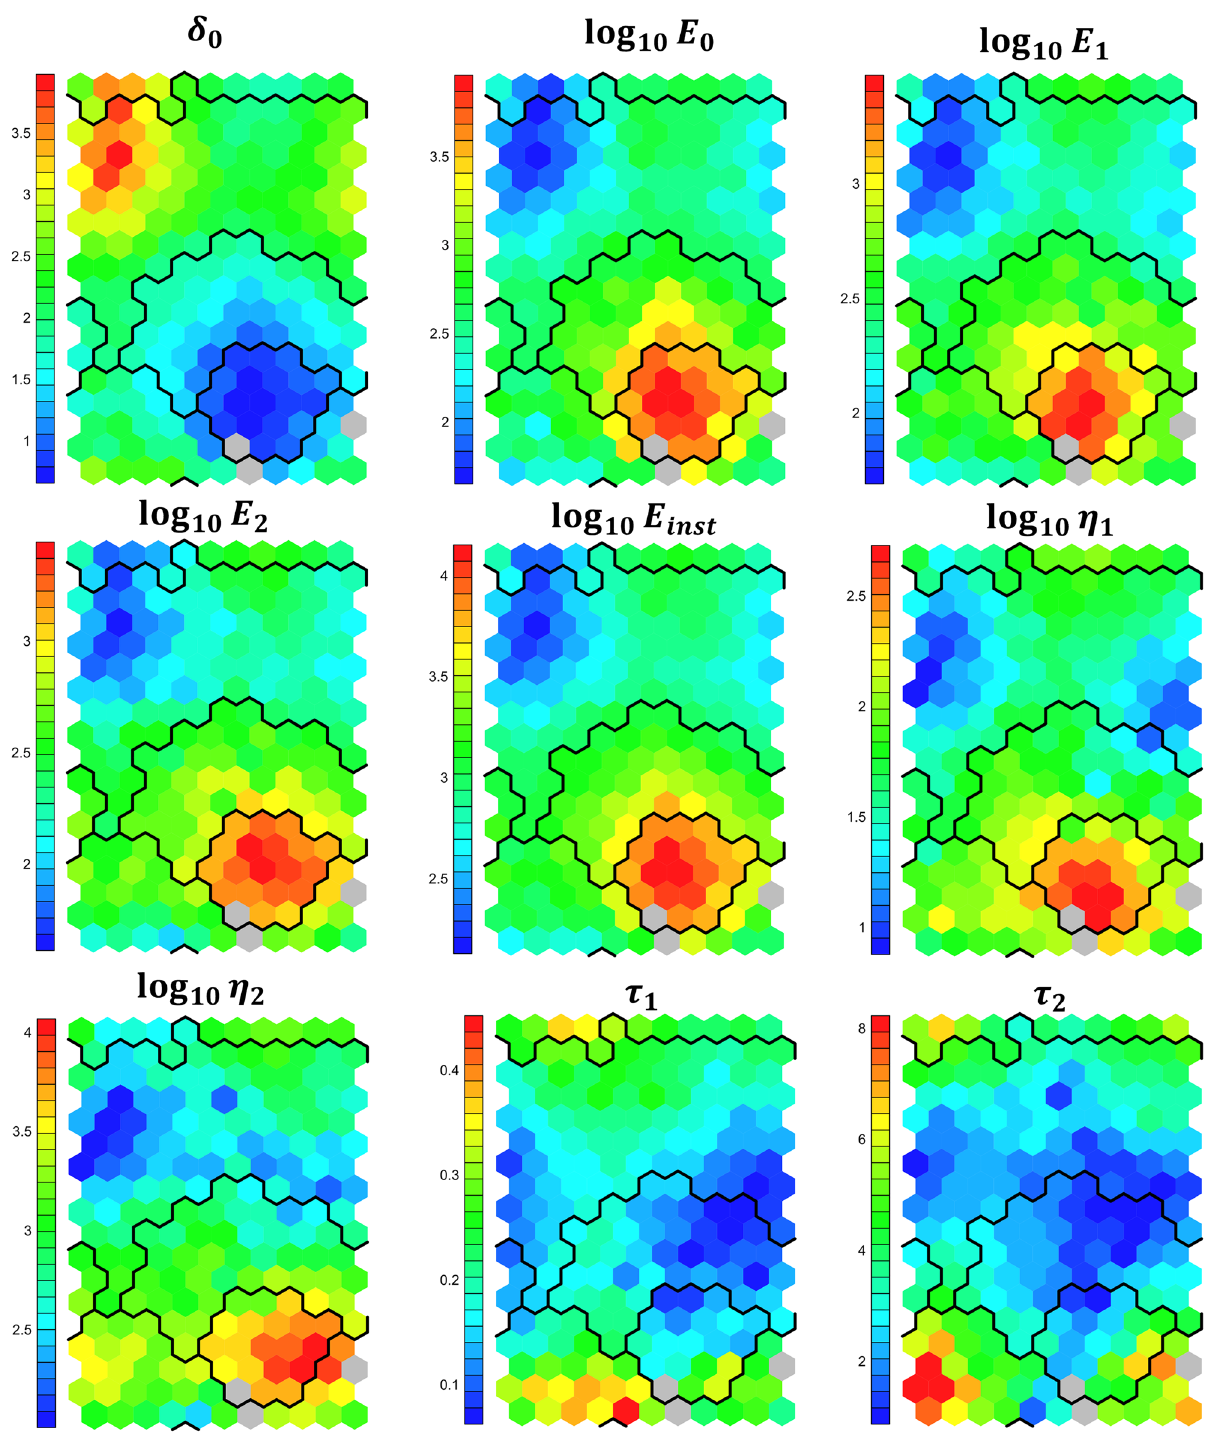
Figure 2. Component maps of the nine input parameters after training the SOMs. The colour coding indicates the magnitude of the nodes. The moduli and viscosities are logarithmically scaled to allow for comparison. The black lines show the borders of the four calculated clusters. Grey nodes have no measurements placed in